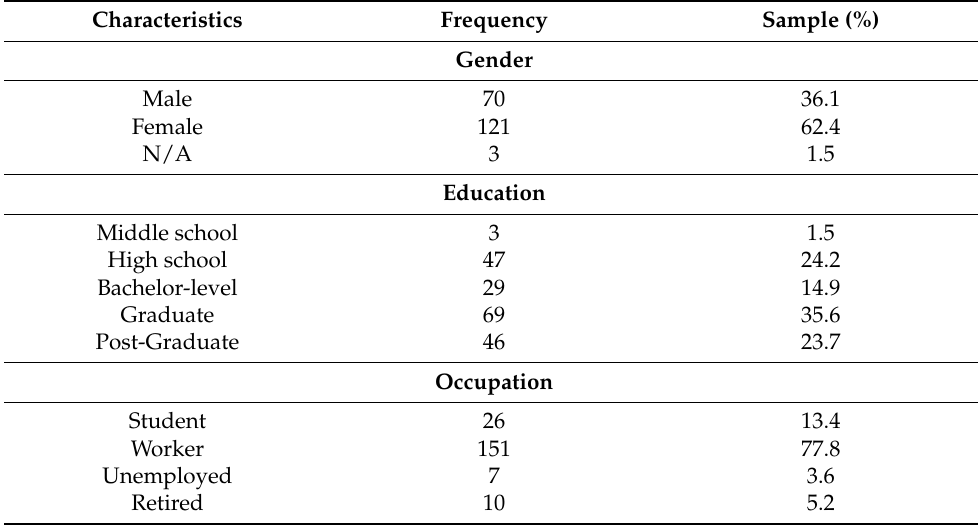
Table 1. Descriptive statistics of the sample ( n =